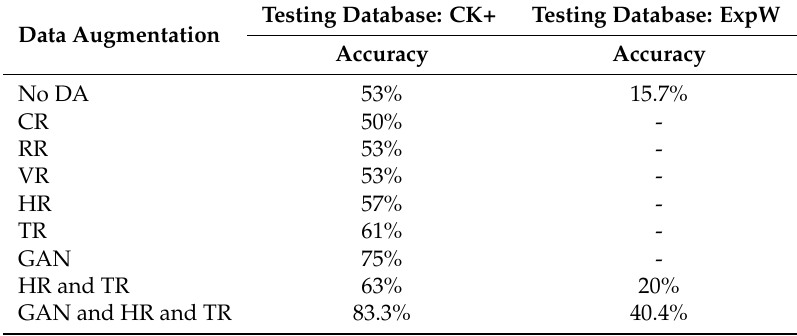
Table 1. Comparison of the overall emotion recognition accuracy achieved by the proposed FER system considering different DA techniques. Training database, KDEF; testing databases, CK+ and